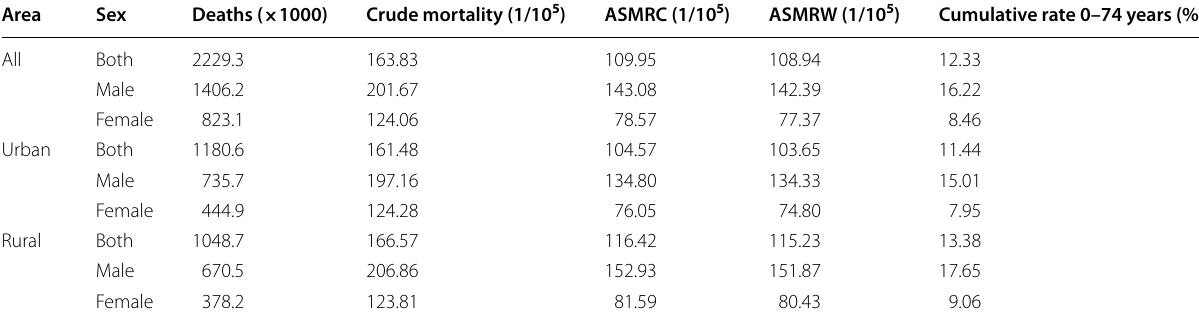
Table 2 Estimated cancer mortality in China in 2013. This Table was published previously and is reproduced with permis- sion from China Cancer